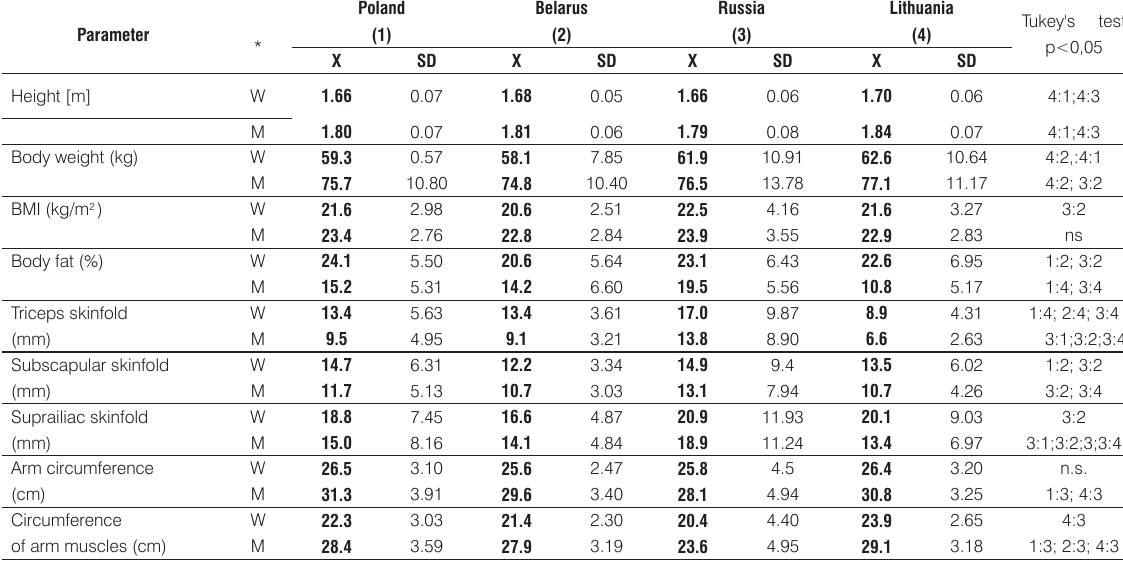
Table 2. Anthropometric characteristics of female and male students.